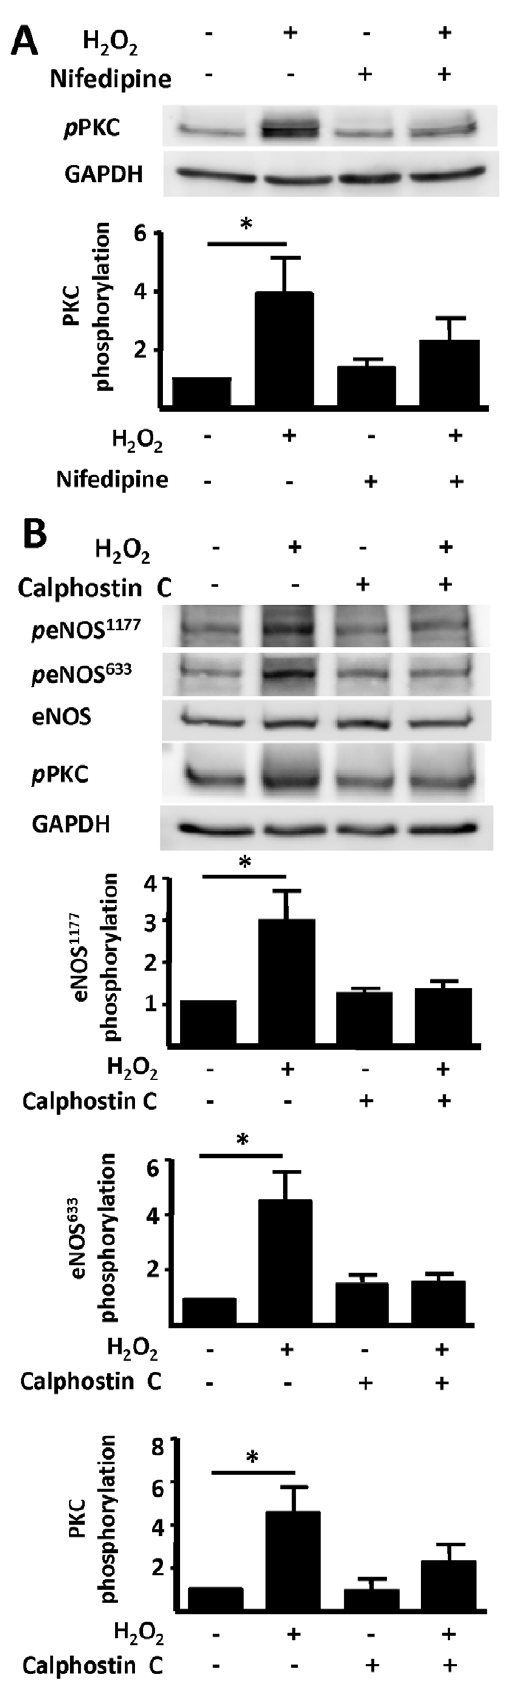
Figure 3. Effects of calphostin C on H 2 O 2 -promoted eNOS phosphorylation. In panel A, cardiac myocytes were incubated with nifedipine (100 m M, 30 min) or vehicle, then treated with H 2 O 2 (25 m M) and analyzed in immunoblots probed with phospho-protein kinase C (PKC) phosphorylation ( b II Ser660) or GAPDH antibodies. Panel B shows a representative experiment looking at the effects of calphostin C on H 2 O 2 -promoted eNOS phosphorylation. Freshly isolated adult murine cardiac myocytes were treated with calphostin C (1 m M, 30 min) or vehicle before treatment with H 2 O 2 (25 m M, 15 min). Cell lysates were resolved by SDS-PAGE and probed using antibodies directed against phospho-eNOS Ser1177, phospho-eNOS Ser633, total eNOS, phospho- PKC, or GAPDH. Densitometric analyses from pooled data, plotting the fold increase of the degree of protein phosphorylation (in arbitrary units) relative to the signals present in unstimulated cardiac myocytes are also shown in this figure. Each data point represents the mean 6 S.E. derived from three independent experiments, *indicates p , 0.05 for respective phospho-protein versus unstimulated cells ( ANOVA